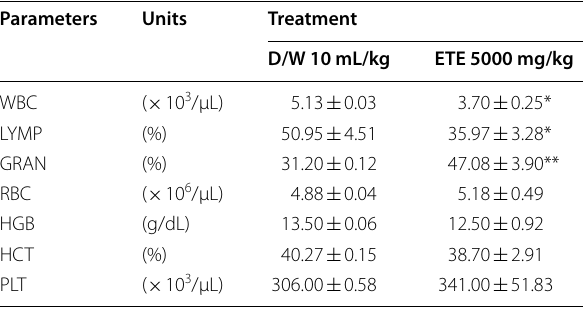
Values are mean